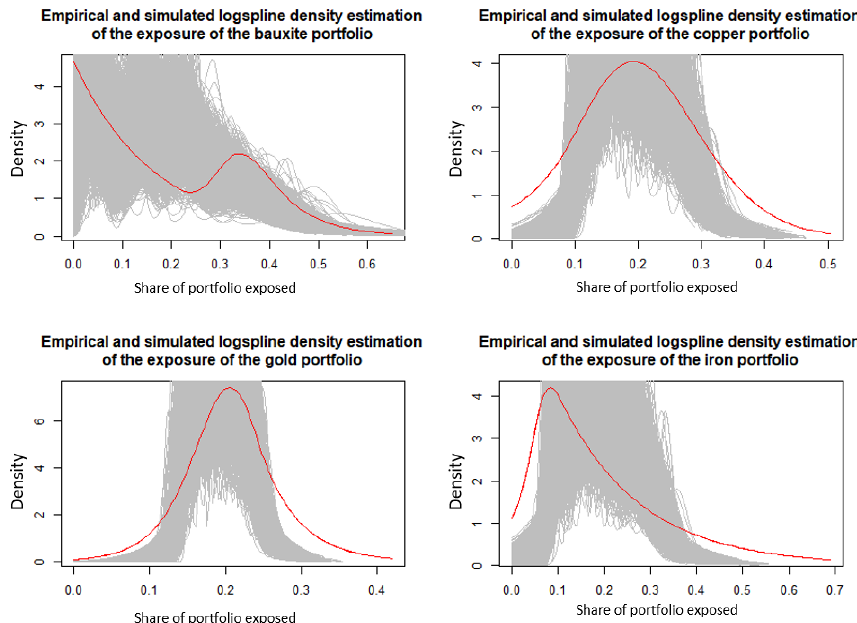
Figure 1. Empirical (red) and independent and identically distributed process-simulated (gray) density estimation of the yearly share of global production exposed to a wet or dry 10-year event according to the 12-month SPEI for four different portfolios.